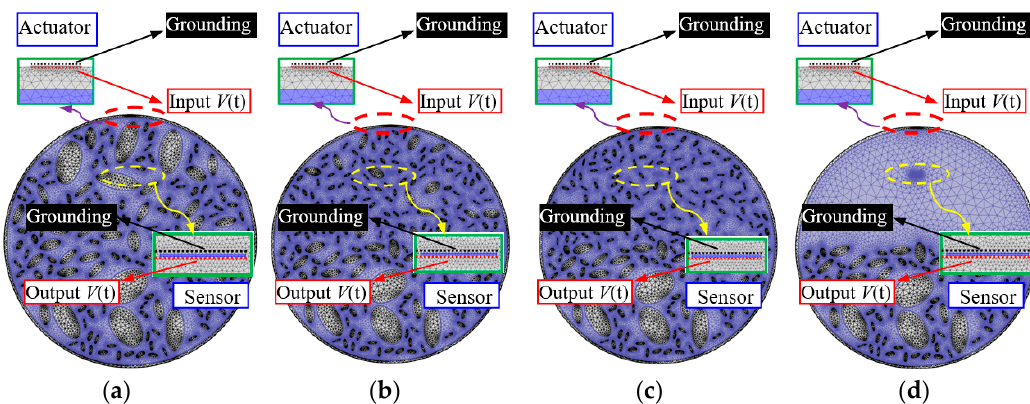
Figure 3. Meshing scheme of the piezoelectric lead zirconate titanate–circular concrete-filled steel tubulars (PZT-CCFST) coupling model (for 20 kHz) ( a ) without segregation; ( b ) coarse aggregates segregation; ( c ) coarse and middle aggregates segregation; ( d ) all aggregates segregation.